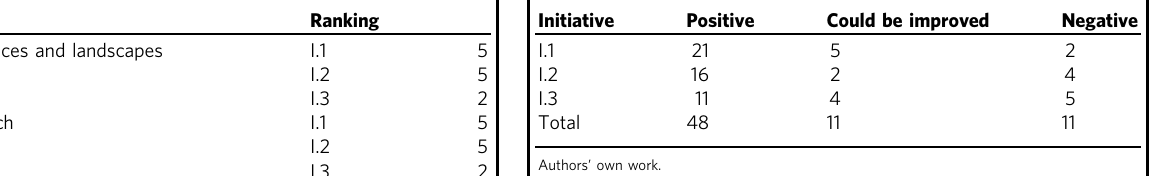
Table 7 Dimensions of the model (TB.1) and the level of development. Dimensions